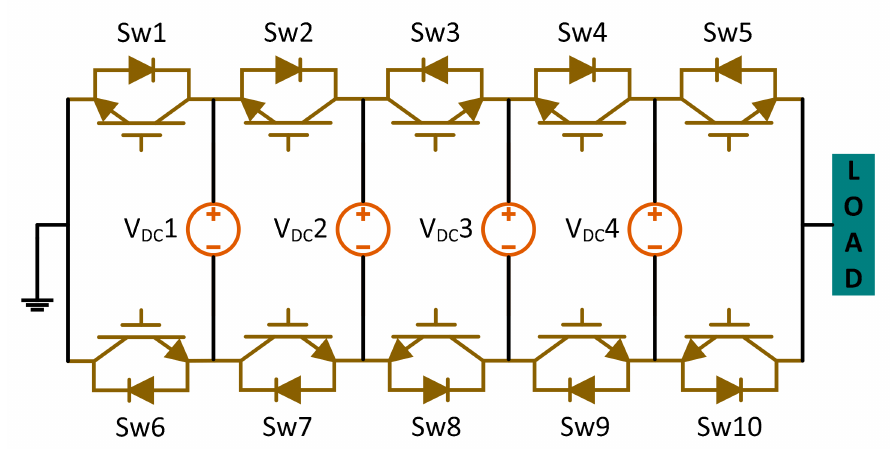
Figure 22. Topology of packed U-cell multilevel inverter.